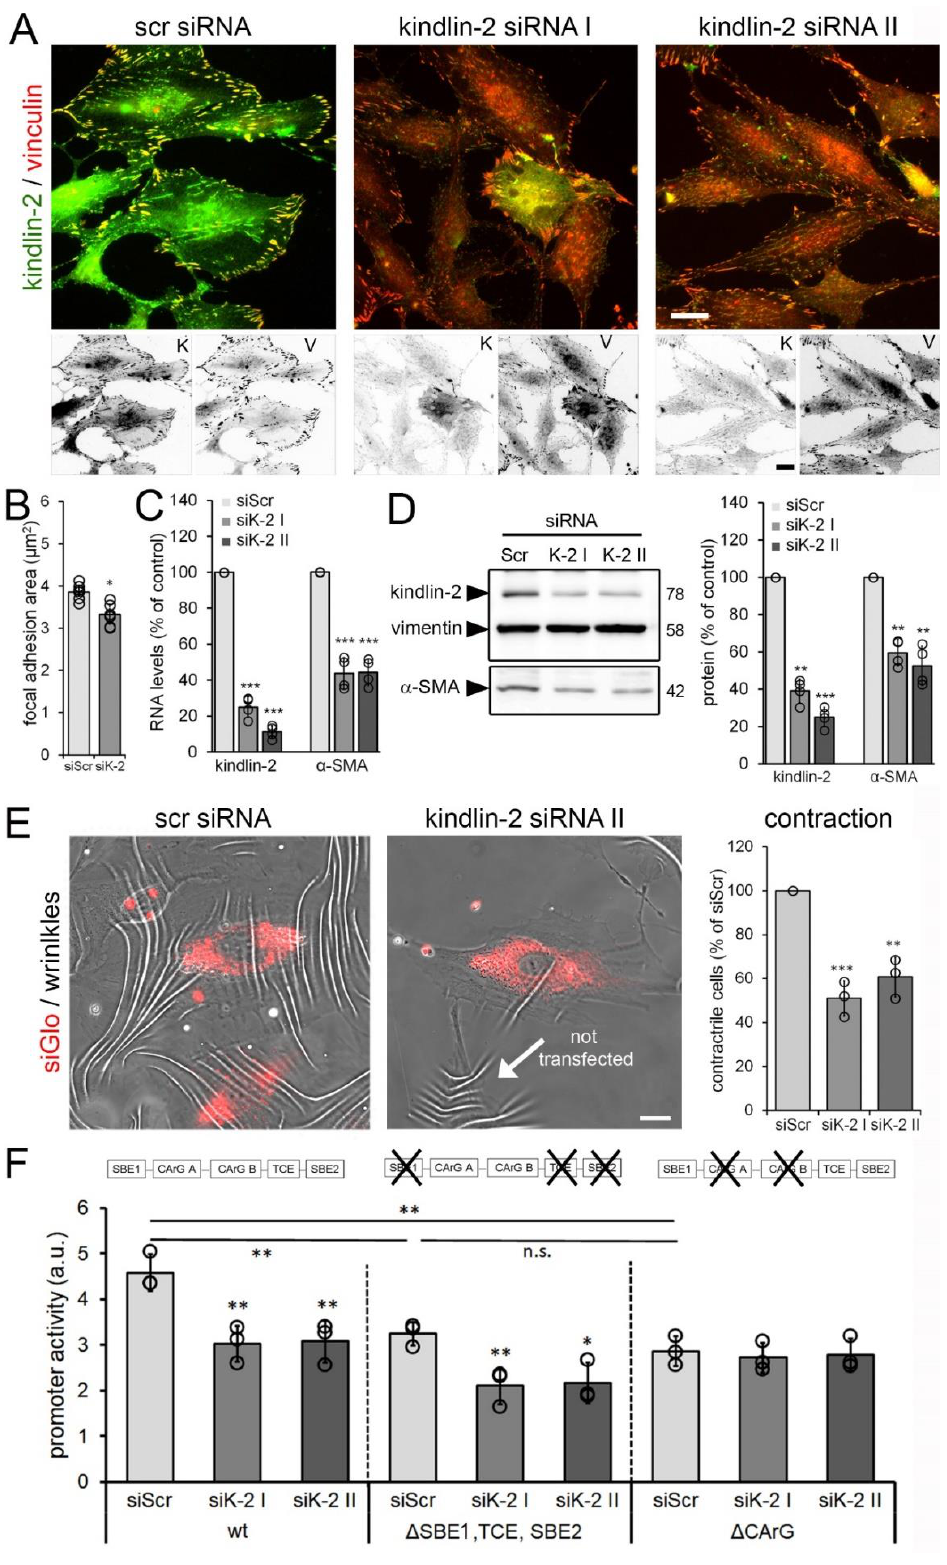
Figure 5. Kindlin-2 knockdown results in reduced myofibroblast activation and contraction. Human cardiac fibroblasts (hCF) were transfected with non-targeting scrambled (scr) and two different silencing RNAs (siRNAs) (siK-2 I & II) targeting the open reading frame of human kindlin-2. After 48 h, cells were analyzed by ( A ) immunostaining for kindlin-2 (K, green and inverted fluorescence) and vinculin (V, red and inverted fluorescence), followed by ( B ) quantification of focal adhesion (FA) sizes based on vinculin signal, ( C ) real-time PCR, and ( D ) quantitative immunoblotting normalized to